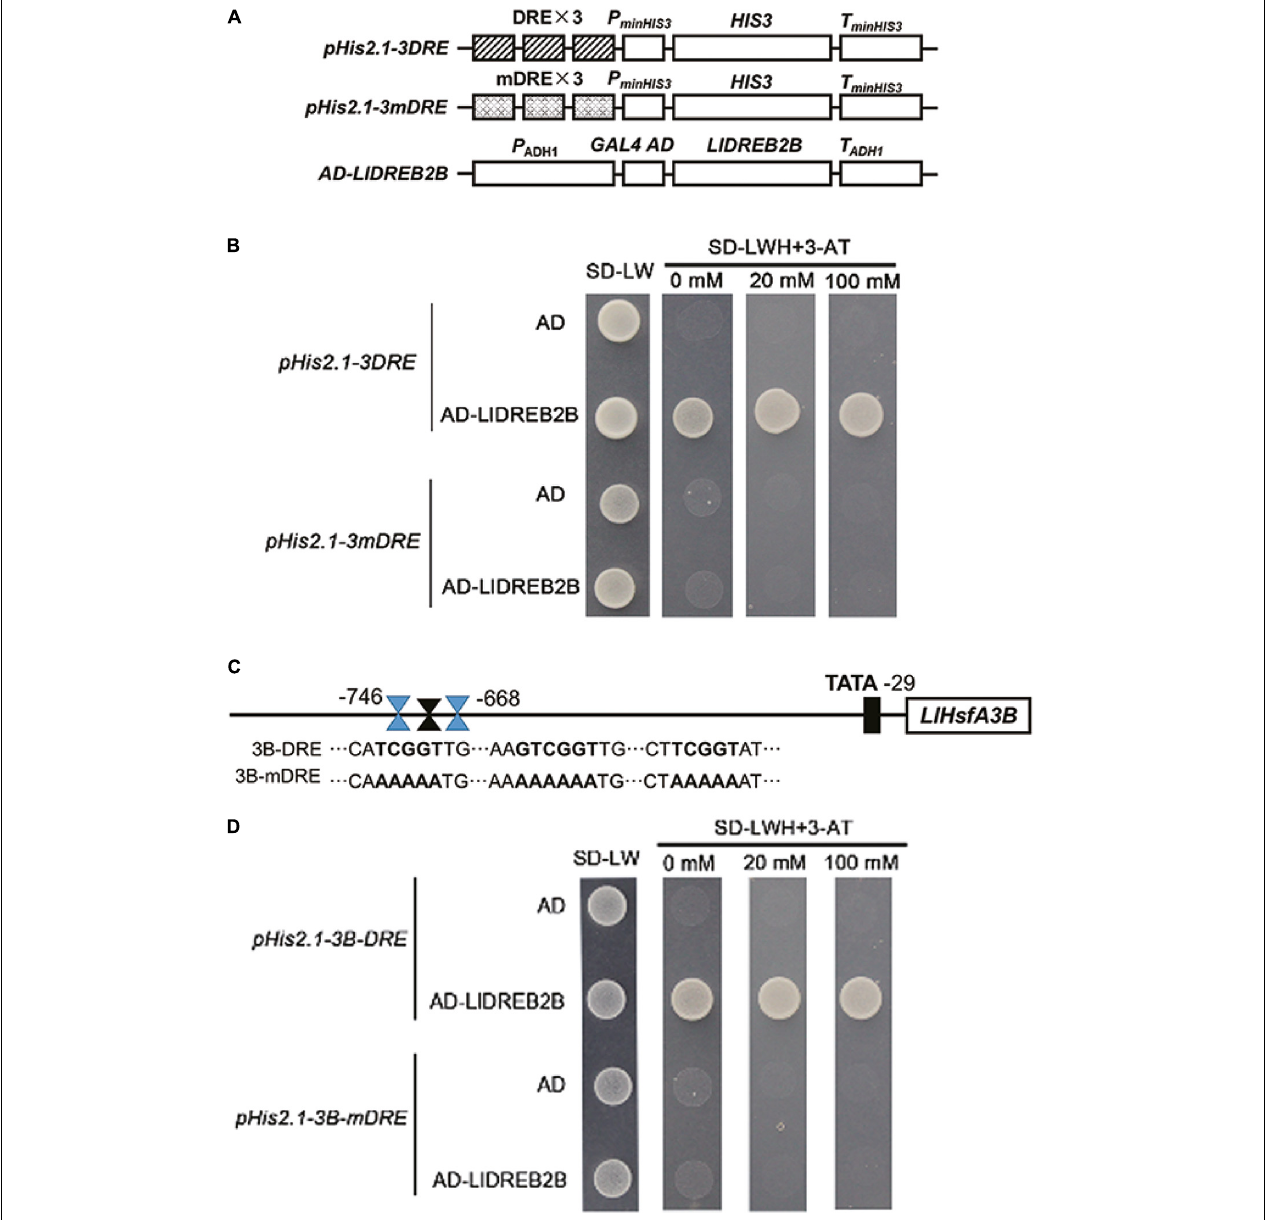
FIGURE 5 | Analysis of the DRE binding ability of LlDREB2B. (A) Schematic diagrams of the required vectors for yeast one-hybrid assay. The pHis2.1 vector contained three tandem repeats of a DRE (TATACTACCGACATGAGTTC) or mutant DRE (TATACTAAAAAAATGAGTTC) sequence and the HIS reporter gene. (B) Yeast strain Y187 was co-transformed with bait ( pHis2.1-3DRE or pHis2.1-3mDRE ) and a prey ( pGADT7 or pGADT7-LlDREB2B ) construct. Interaction between bait and prey was determined by cell growth on SD medium lacking Trp, Leu, and His (SD-WLH) and containing the indicated concentrations of 3-AT. (C) Sequences of the LlHsfA3B promoter and its DRE-mutated version. (D) Yeast strain Y187 was co-transformed with bait ( pHis2.1-3B-DRE or pHis2.1-3B-mDRE ) and a prey ( pGADT7 or pGADT7-LlDREB2B ) construct. Interaction between bait and prey was determined by cell growth on SD-WLH containing the indicated concentrations of